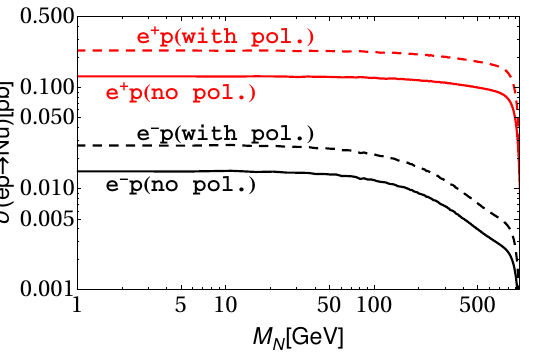
Figure 3 . Production cross-section of ep → Nu with and without 80% left (right) polarised e − ( e + )